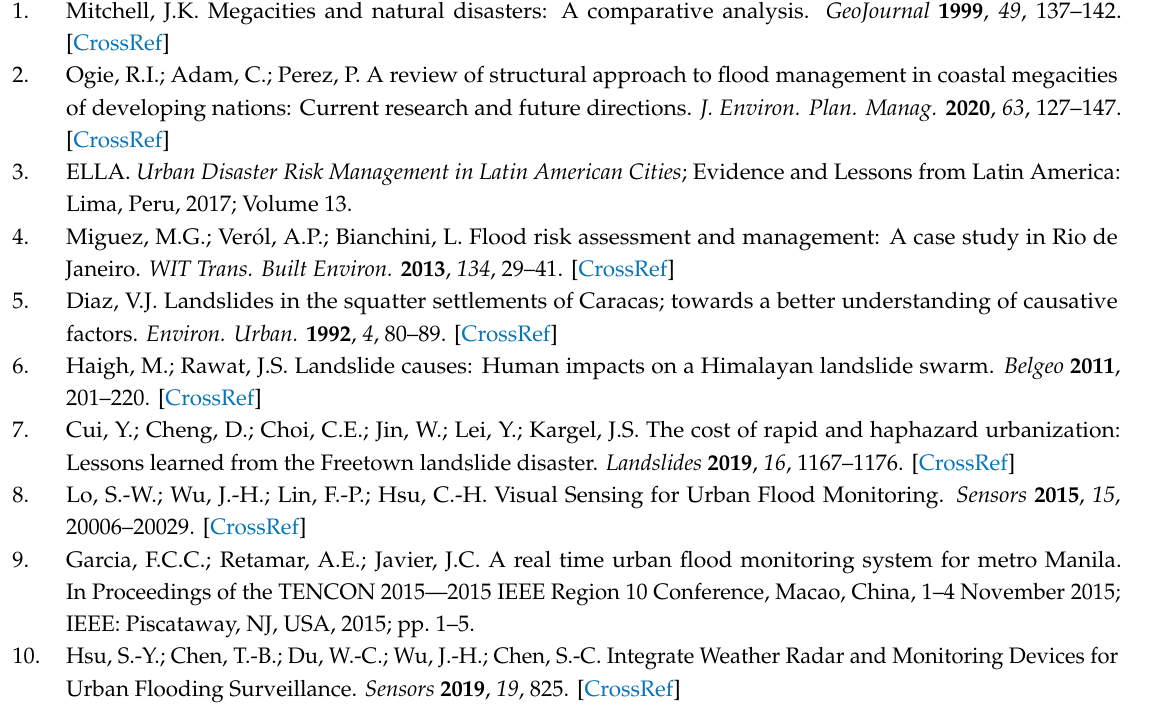
Figure S1: POD and FAR maps for rainfall, RZSM and TR events derived from experiments with IMERG Early and IMERG Final at the percentile threshold ≥ 80% chance of occurrence, Figure S2: POD and FAR maps for rainfall, RZSM and TR events derived from experiments with IMERG Early and IMERG Final at the percentile threshold ≥ 90% chance of occurrence, Figure S3: POD and FAR maps for rainfall, RZSM and TR events derived from experiments with IMERG Early and IMERG Final at the percentile threshold ≥ 95% chance of occurrence, Figure S4: POD and FAR maps for rainfall, RZSM and TR events derived from experiments with IMERG Early and IMERG Final at the percentile threshold ≥ 98% chance of